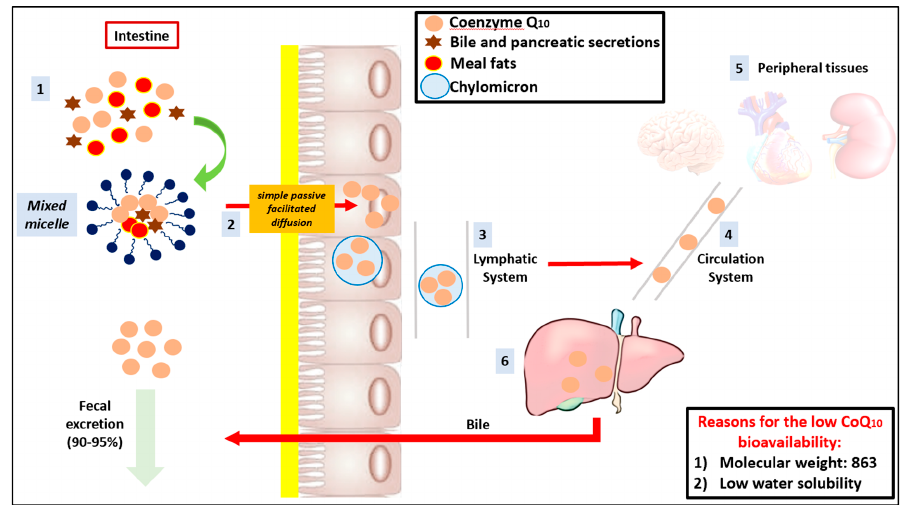
Figure 3. Coenzyme Q 10 physiology: (1) CoQ 10 arrives in intestinal lumen with exogenus cholesterol after a meal (if administered in fed state. (2) CoQ 10 is taken up from the mixed micelles, together with the meal fats and bile and pancreatic secretions, which facilitate its solubilization and the entrance in the enterocytes via the simple passive facilitated di ff usion. (3) CoQ 10 is incorporated in the chylomicrons and subsequently reaches the bloodstream through the lymphatic system. (4) Through the bloodstream, CoQ 10 is distributed to peripheral tissues (5) and to the liver (6), where it is partially re-excreted in the bile and eliminated with the